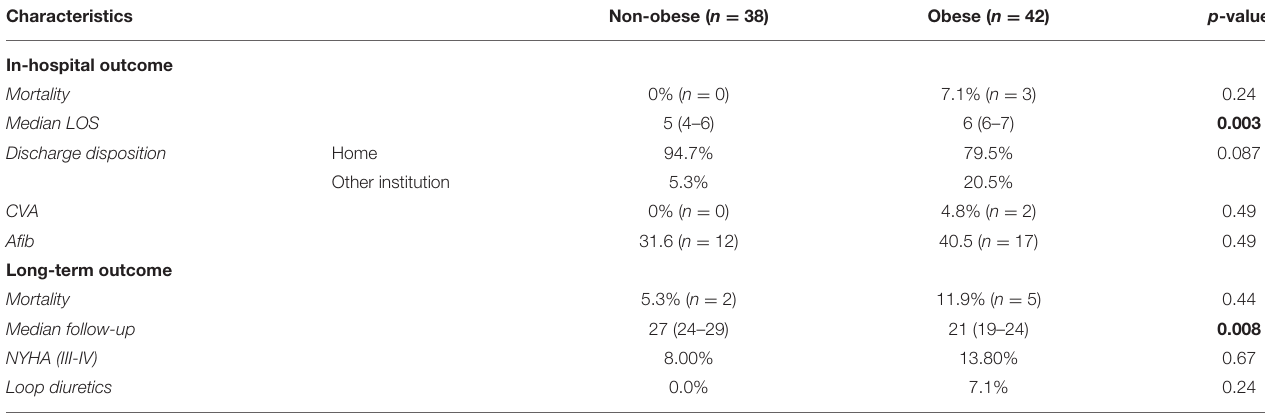
TABLE 4 | Patient outcomes. Characteristics In-hospital outcome